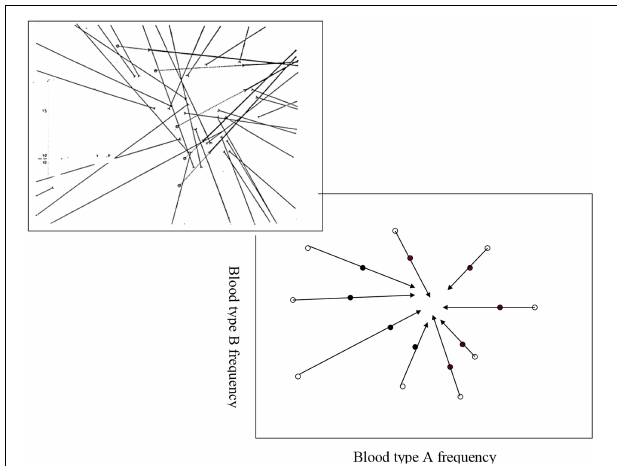
FIGURE 3 | Muhsam’s attempt to identify the frequencies of the ABO blood type of the Jewish forefathers: vectors from “gentile environments” (open circles) to the corresponding “genuine” Jewish eidoth (closed circles). Right-lower, expected model; left-upper, observed.